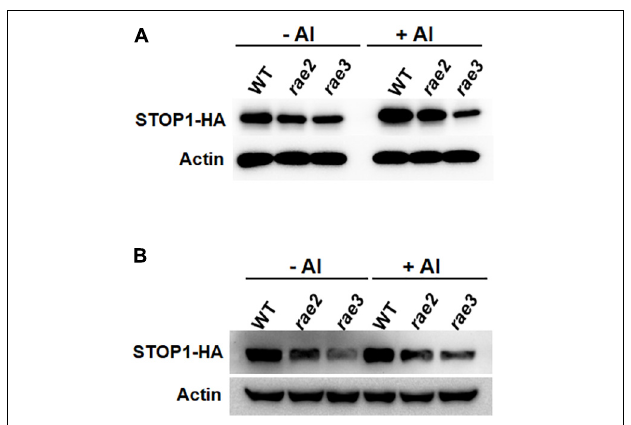
FIGURE 5 | Mutation of RAE2 reduces STOP1 protein accumulation. (A,B) Comparison of STOP1-HA protein level in roots (A) and shoots (B) of WT, rae2 , and rae3 harboring pSTOP1:STOP1-HA transgene. Seedlings with 12 days old were exposed to 0 (–Al) or 30 µ M Al (+Al) for 12 h. The STOP1-HA and internal control actin was detected by anti-HA and anti-actin antibodies,